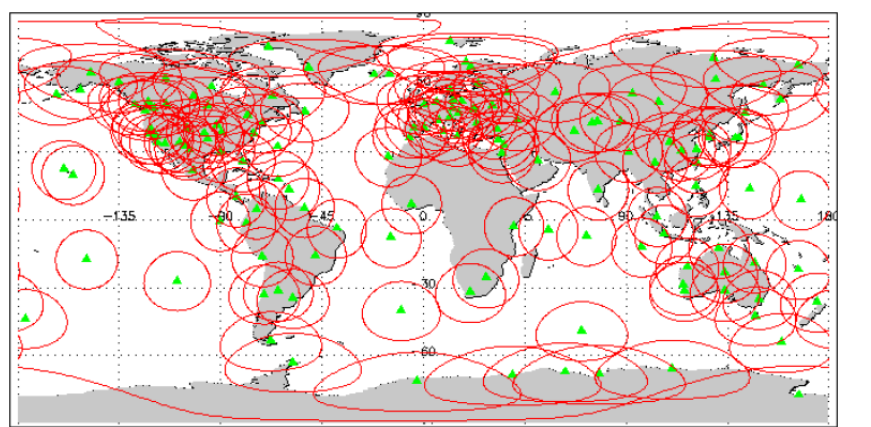
Fig. 1. Global network of ground GPS receivers. The vision areas at 400 km altitudes at the elevation angle 10 о are